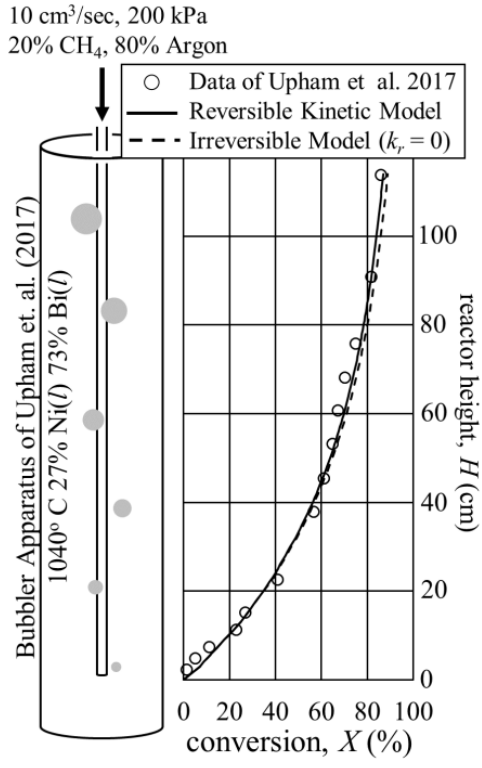
Figure 3. The application of reversible molten methane cracking kinetics to data from Upham et al. 2017 [3].